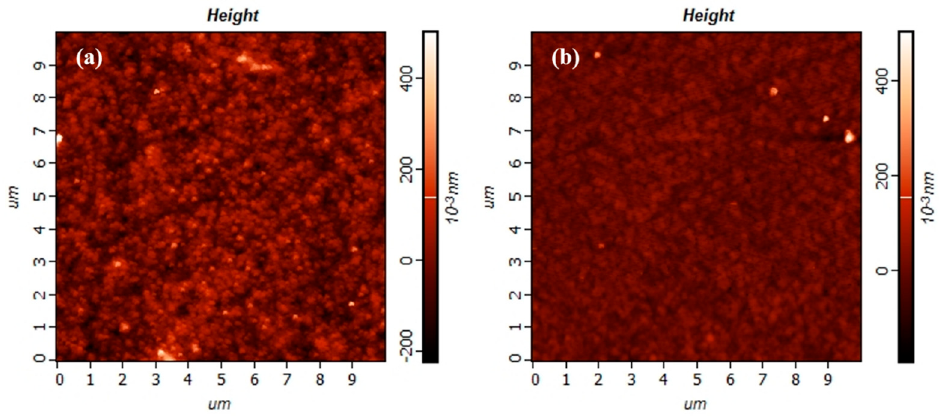
Figure 6. Atomic force microscopy (AFM) height images of PIDT-AQx/PC 71 BM blend film ( a ) as cast and ( b ) thermal annealing at 110 °C for 10 min.